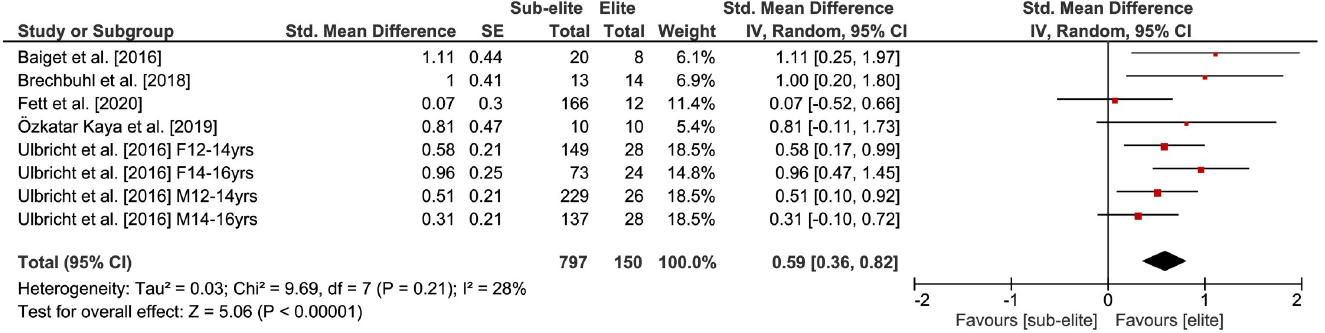
Fig 3. Differences in measures of endurance by competition level (i.e., elite vs. sub-elite tennis players). CI = confidence interval, df = degrees of freedom, SE = standard error, IV = inverse variance.